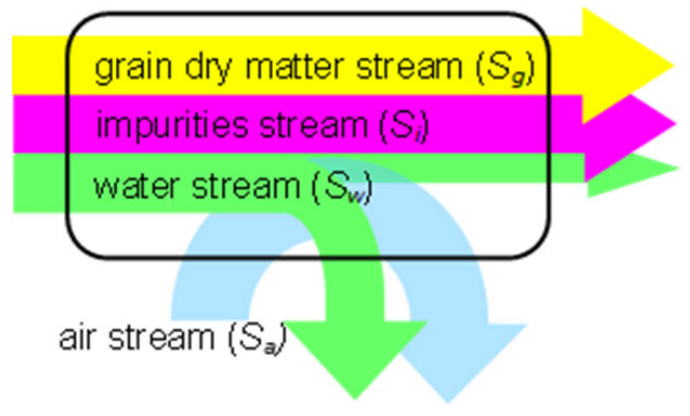
Figure 1. Flow and division of streams during the drying process.